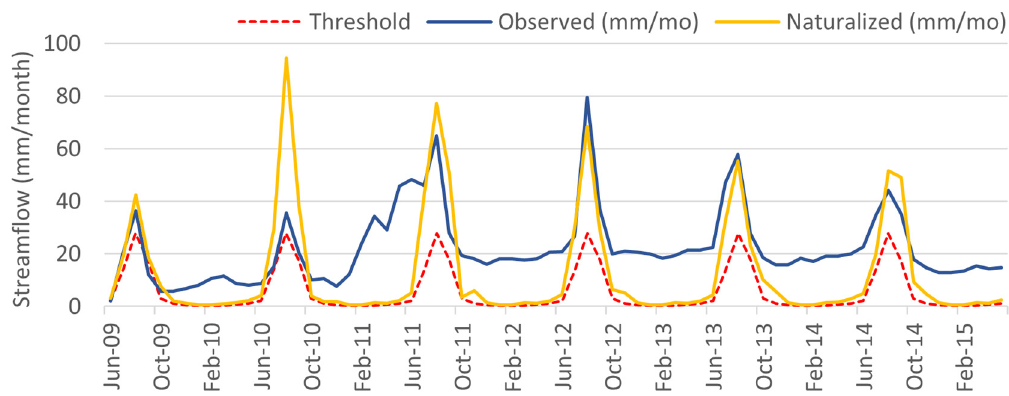
Figure 9. Naturalized vs. disturbed period streamflow (mm/month) for the period 2009–2015.